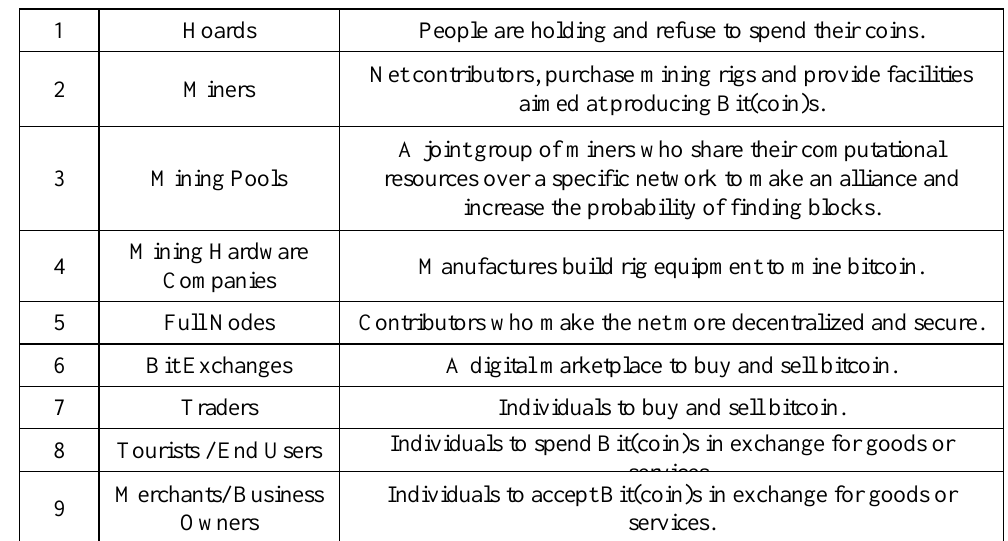
Table 1. Bitcoin Early